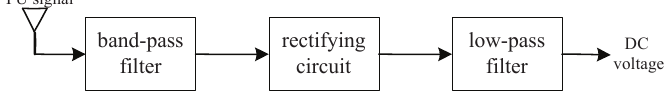
Figure 1. Energy-harvesting circuit. PU: primary user; and DC: direct